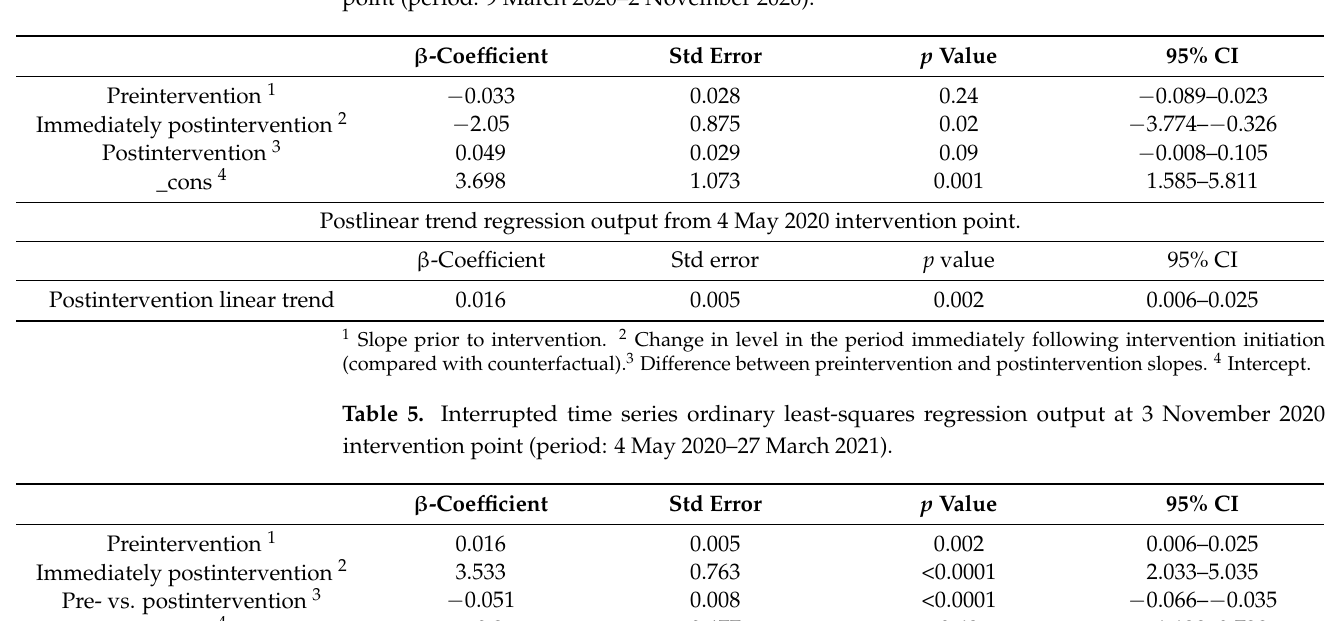
Table 4. Interrupted time series ordinary least-squares regression output at 4 May 2020 intervention